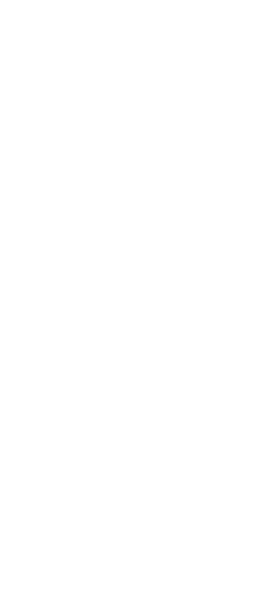
Table 13. Comparison with actual